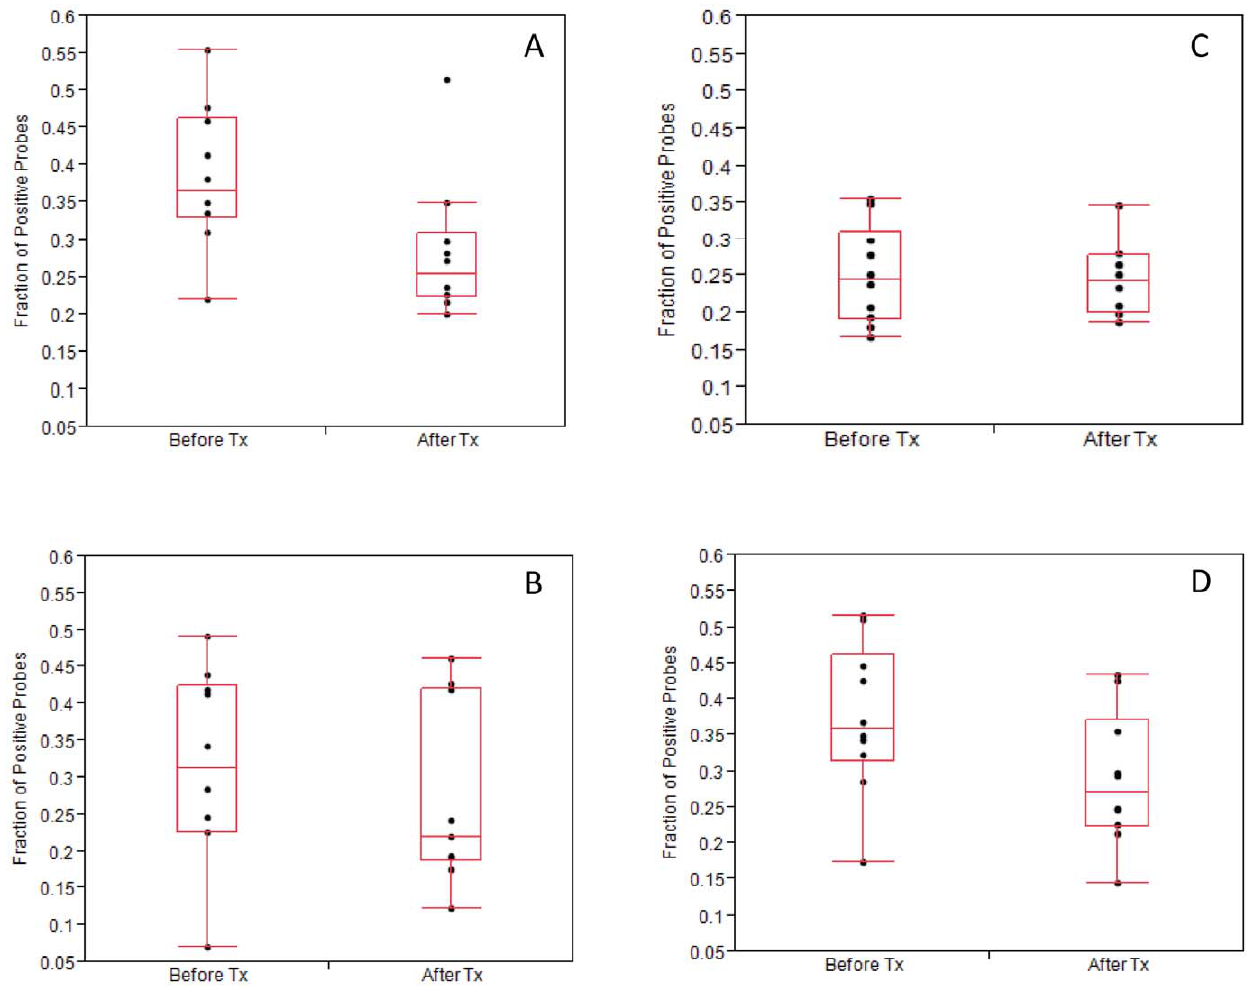
Figure 1. Bacterial Taxa by Site; Before and After Transplantation. Fraction of positive bacterial probes for each patient, before and after transplantation for saliva (A), plaque (B), buccal (C) and tongue (D) brushings. Each point represents a fraction of positive probes for each patient. Box plots show medians and lower and upper quartiles. The sample size varies slightly by site and by time for each site does not include all eleven patients.